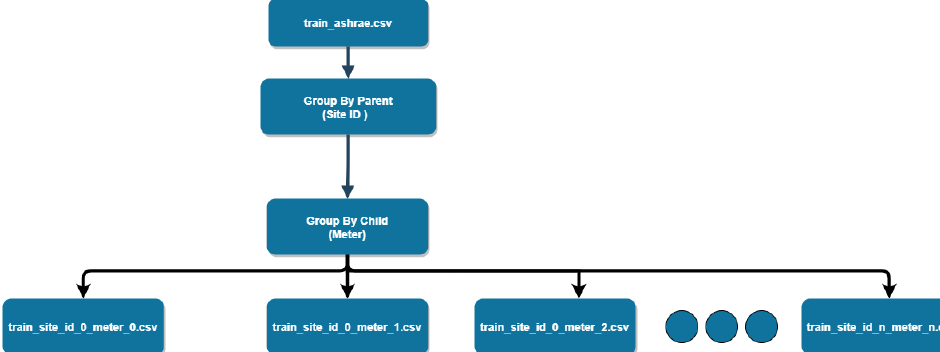
Figure 4. Generating CSVs through experimentation.